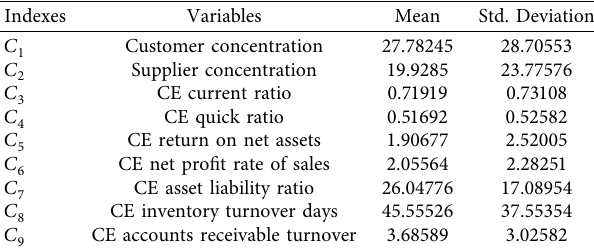
Table 2: List of independent variables for supply chain operations